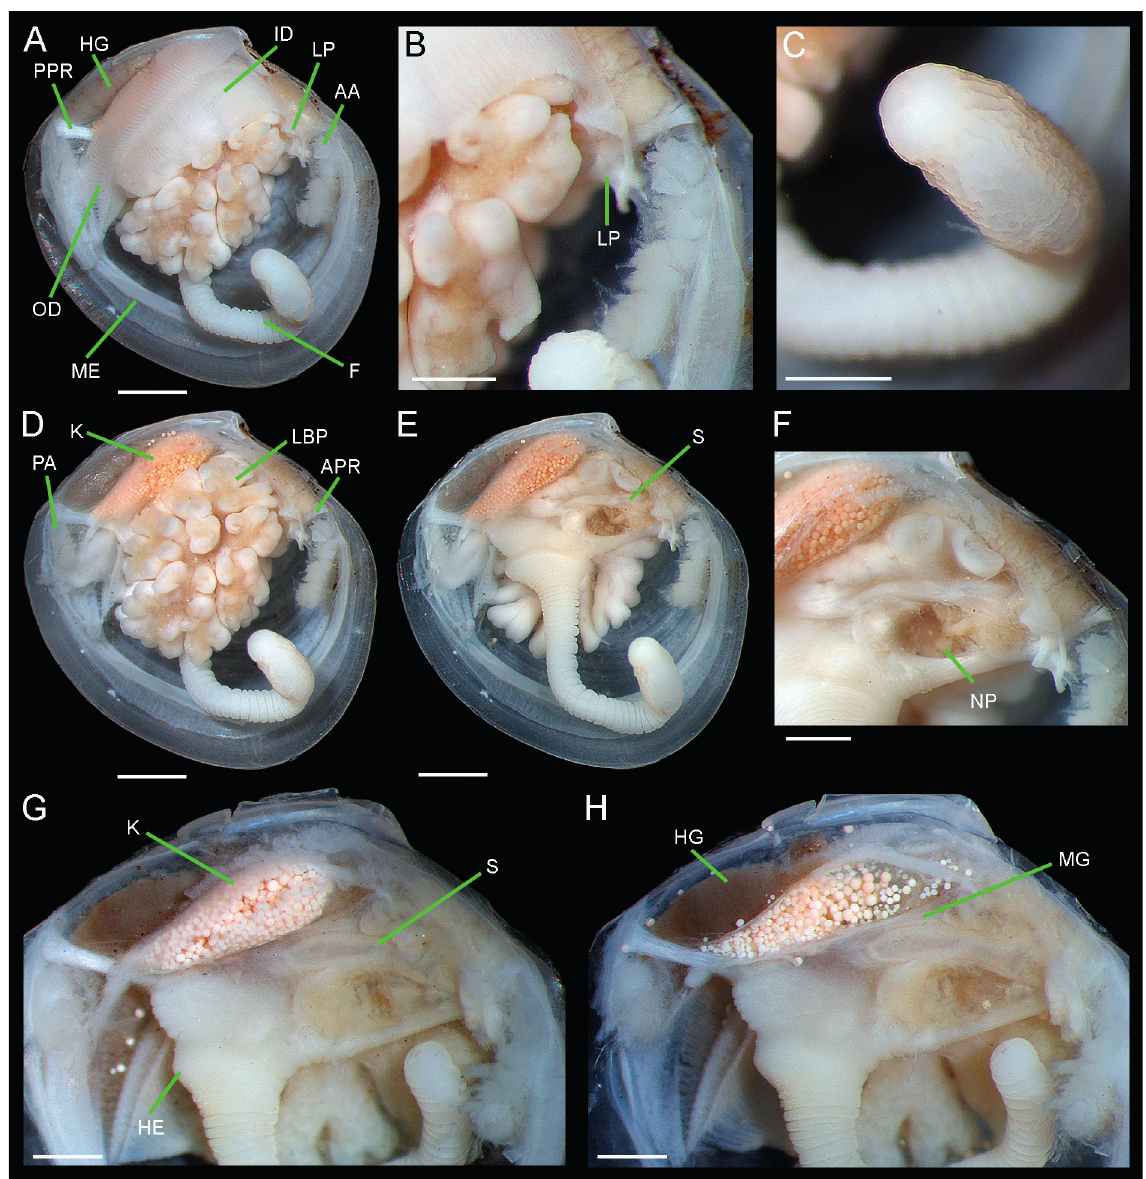
Fig. 16. Thyasira kharkovensis sp. nov. A . Gross anatomy after removal of right valve and mantle, shell length 5.2 mm (MIMB 43830). B . Labial palps (MIMB 43830). C . Bulbous portion of foot (MIMB 43830). D . Gross anatomy after further removal of right ctenidium (MIMB 43830). E–F . Gross anatomy after further removal of right lateral body pouch (MIMB 43830). G–H . Digestive system, shell length 4.5 mm (MIMB 43826). Abbreviations: see Material and methods. Scale bars: A, D–E = 1 mm; B–C, F–H = 500